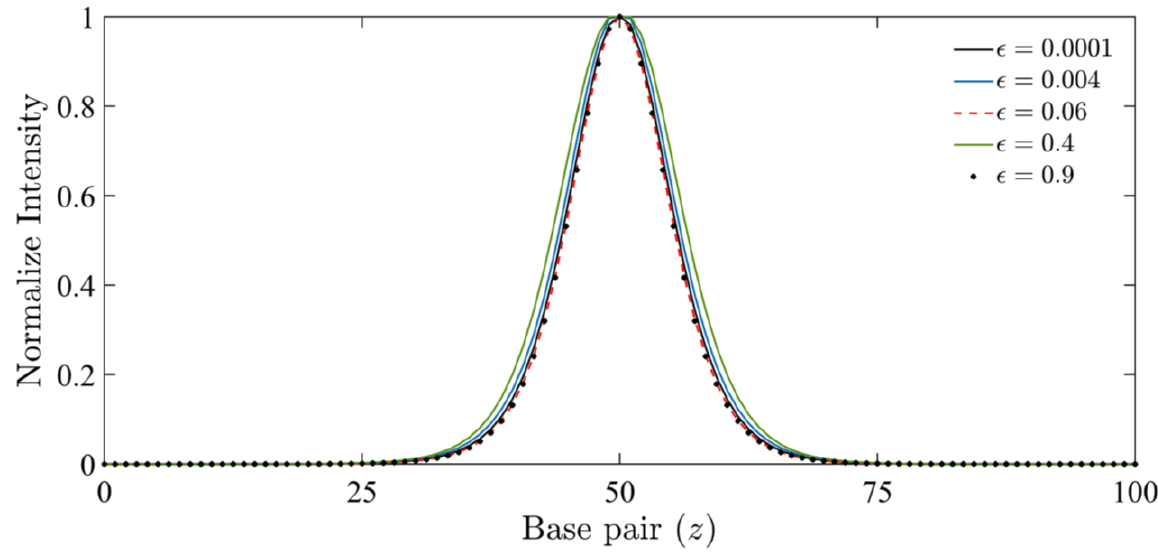
Figure 4. Soliton-like of DNA system in the NH Thermostat for the several values of the perturbation parameter ε = 0.0001, ε = 0.004, ε = 0.06, ε = 0.4, and ε =